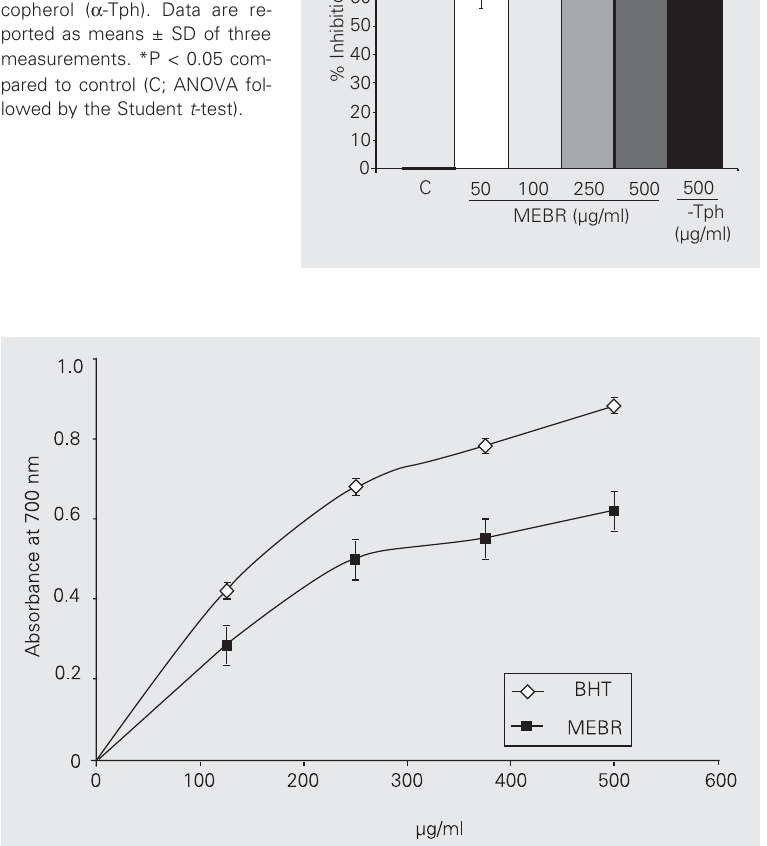
Figure 2. Reducing power of a methanol extract of Bauhinia racemosa (MEBR, squares) and butylated hydroxy toluene (BHT, diamonds). Data are reported as the means ± SD for three measurements. P < 0.01 compared to control (% inhibition by control = 0%; ANOVA followed by the Student t